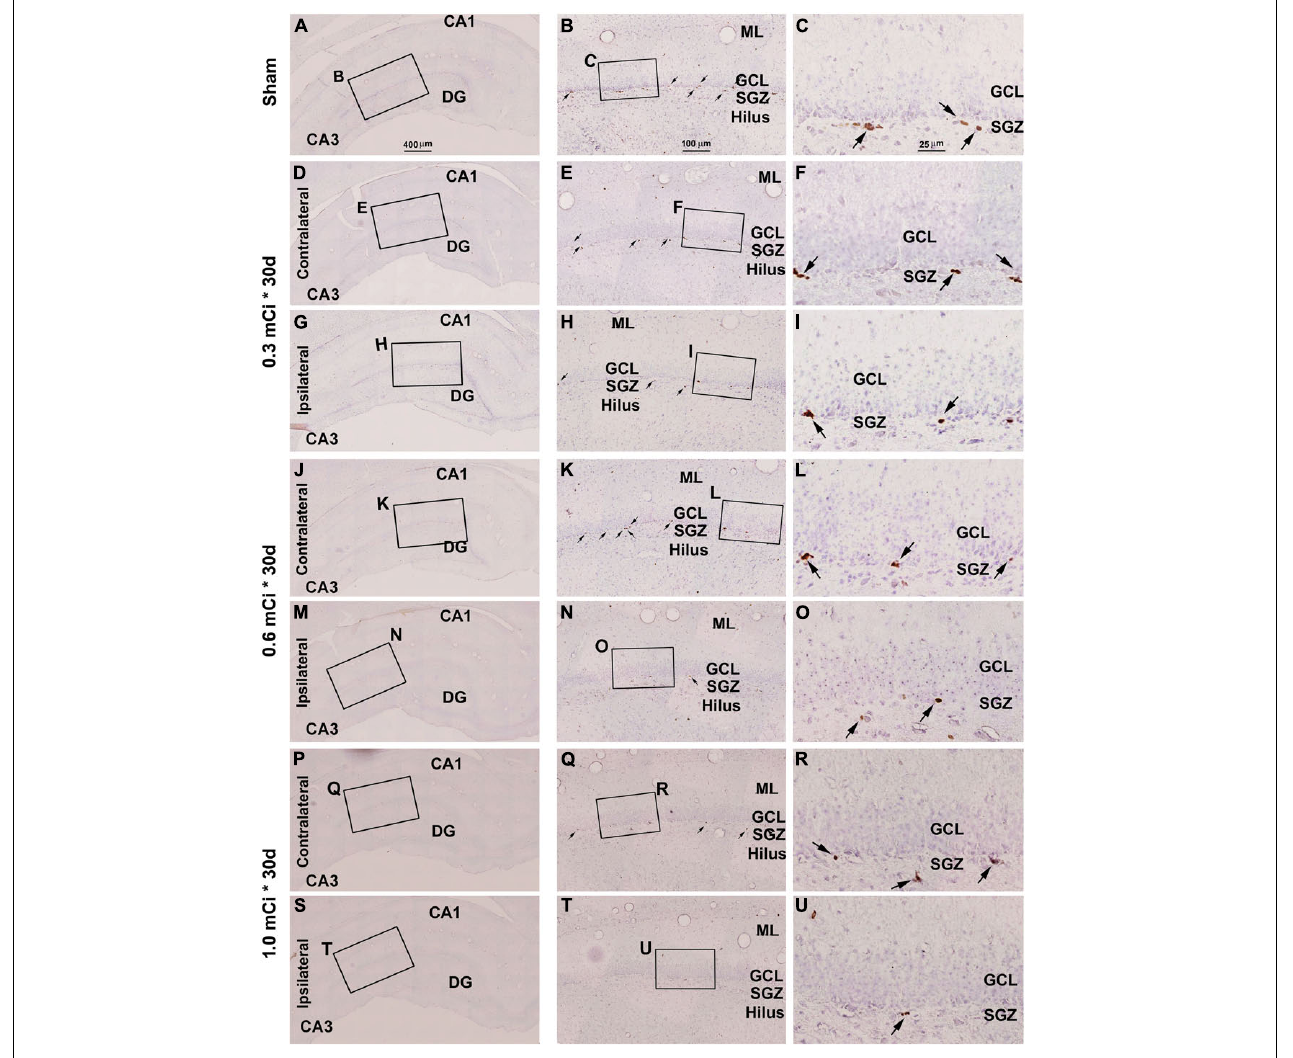
FIGURE 4 | Effect of 0.3–1.0-mCi 125 I seed radiation on Ki67-immunolabeled (+) cells of the hippocampal dentate gyrus at 30 days after implantation. Representative images of Ki67 + (brown) cells with hematoxylin counterstain (blue) from individual animal groups are illustrated as indicated. The left panels (A,D,G,J,M,P,S) are low-magnification images showing the orientation of Ammon’s horn (CA1, CA3) and dentate gyrus (DG), with framed areas enlarged as the middle panels (B,E,H,K,N,Q,T) , in which the boxed areas are further enlarged as the right panels (C,F,I,L,O,R,U) . Ki67 + nuclear profiles (pointed by arrows) are localized at the subgranular zone (SGZ), with some occurring in clusters (C,F,I,L,O,R,U) . The number of Ki67 + cells in the SGZ appears to be reduced in the radiated groups relative to the sham control, more evident in the ipsilateral side (H,I,N,O,T,U) . DG, dentate gyrus; ML, molecular layer; SGZ, subgranular zone; GCL, granule cell layer. Scale bar = 400 µ m in (A) applying to (D,G,J,M,P) ; equal to 100 µ m for (B,E,H,K,N,Q) ; and 25 µ m for (C,F,I,L,O,R)